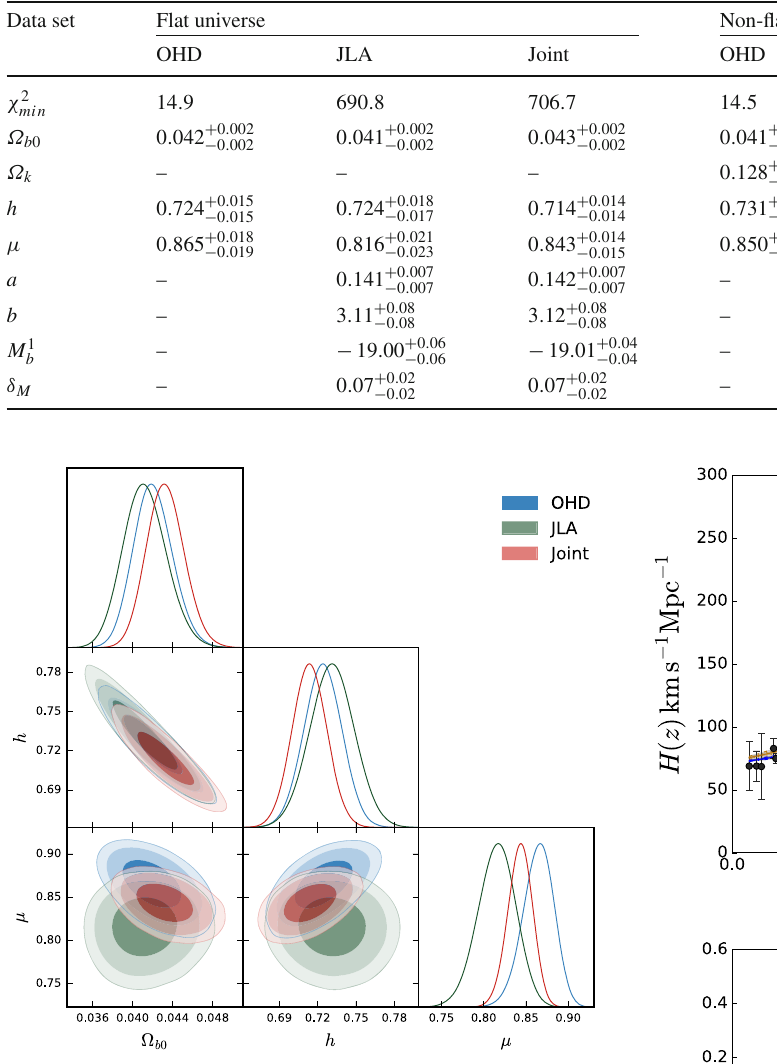
Fig. 1 1D marginalized posterior distributions and the 2D 68%, 95%, 99 . 7% CL for the Ω b 0 , h , and μ parameters in a flat universe